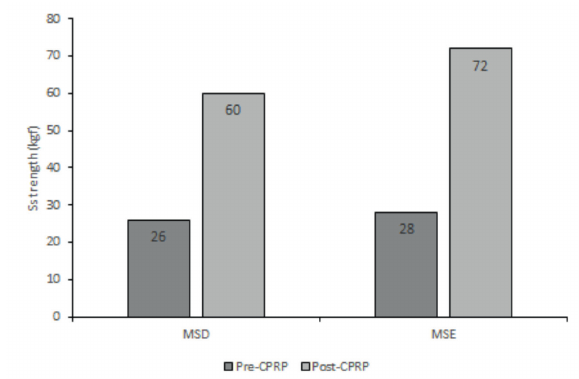
Figure 4 - Comparison of strength (kgf) pre and post CPRP.